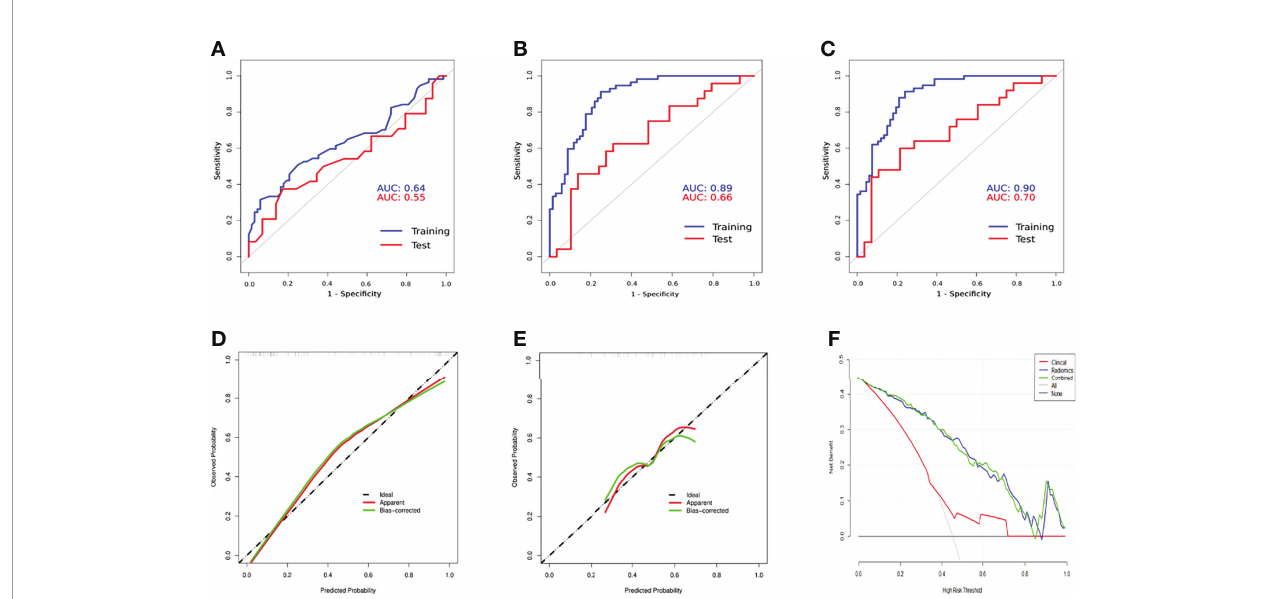
FIGURE 5 | Comparison of receiver operation characteristics curves of the Clin_model (A) , AP+HBP_model (B) , and AP+HBP+Clin_model (C) in training and test subsets. Calibration curves of the AP+HBP+Clin_model for training (D) and test (E) subsets are shown in the lower left and middle panels. The “ apparent ” curve (red) represents the prediction model and the bias-corrected curve (green) describes the prediction model calibrated by 1,000 bootstrap samples. The black dashed diagonal line indicates an ideal situation in which the prediction probability is equal to the observed probability. In the lower right panel (F) , decision curve analysis for the Clin_model, AP+HBP_model, and AP+HBP+Clin_model is shown. The black line represents the net bene fi t of assuming that none of the patients have microvascular invasion (MVI), whereas the gray curve represents the net bene fi t of assuming that all patients have